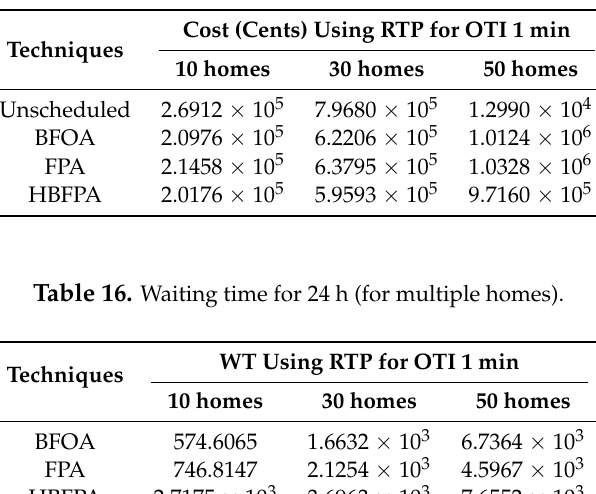
Figure 11. Electricity cost, waiting time and peak to average ratio for multiple homes: (10, 30 and 50) using real time pricing. ( a ) Electricity cost using operational time interval of 1 min; ( b ) Waiting time using operational time interval of 1 min; ( c ) Peak to average ratio using operational time interval of 1 min. Table 15. Electricity cost for 24 h (for multiple homes).